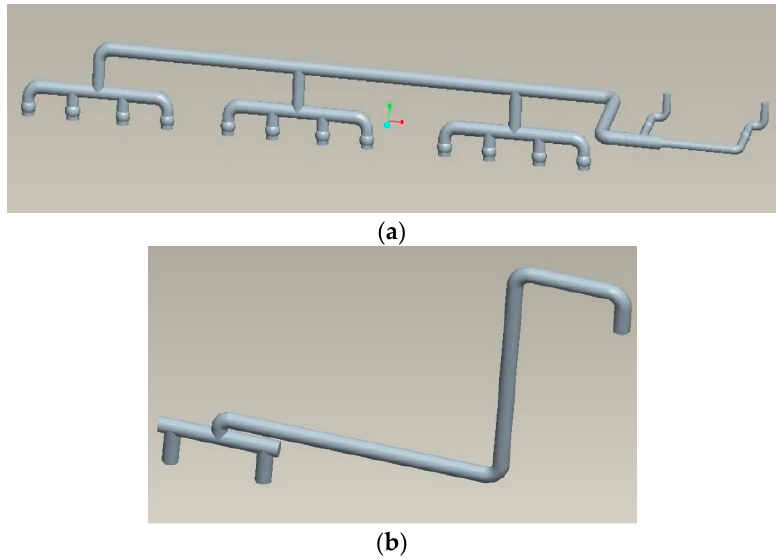
Table 9. The parameters of the pipe fittings of 01-EA002/2. Figure 26. The 3D structure diagram of pipelines, ( a ) The 3D structure diagram of a 01-EA002/1; ( b ) The 3D structure diagram of a 01-EA002/2.